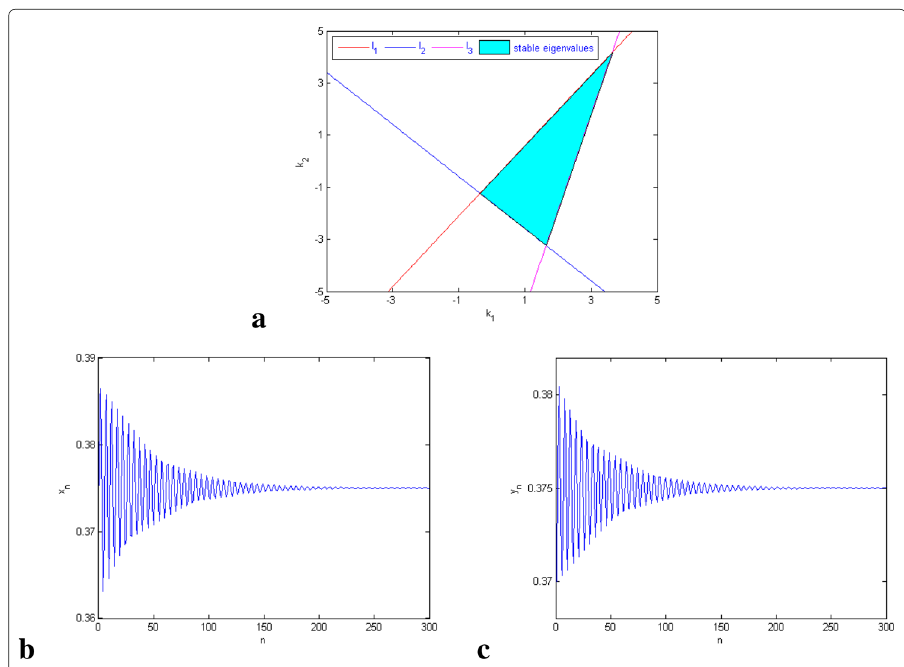
Fig. 6 Controlling chaos in system (15). a Stability region in ( k 1 , k 2 ) plane, ( b , c ). Time series for states x and y ,